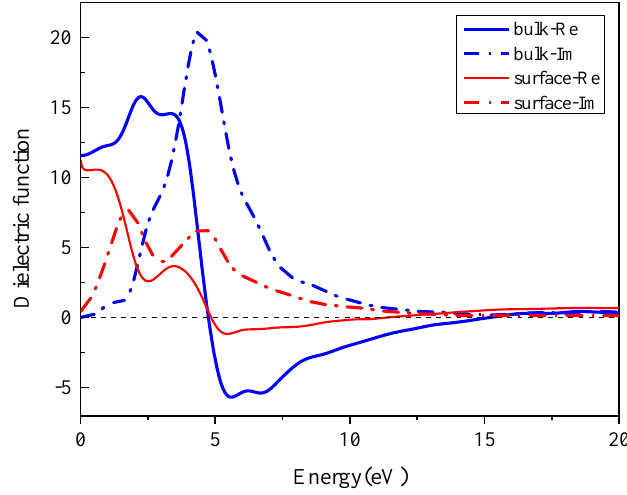
Figure 8. Dielectric function of the In 0.87 Ga 0.13 As 0.25 P 0.75 bulk and surface.